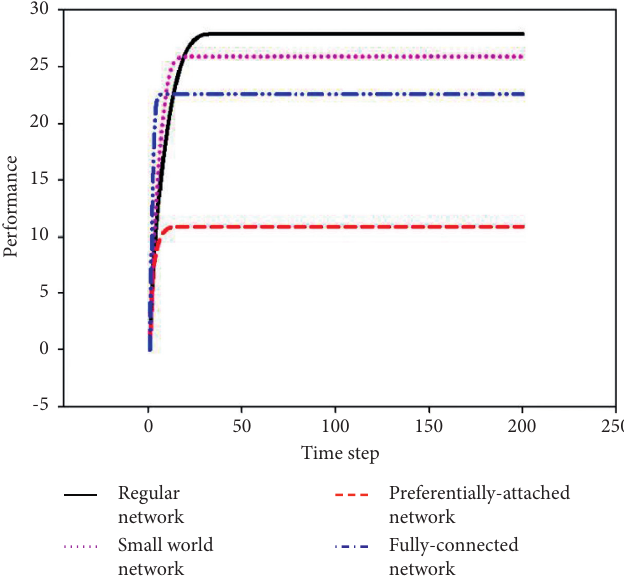
Figure 5: Assessment learning in different network